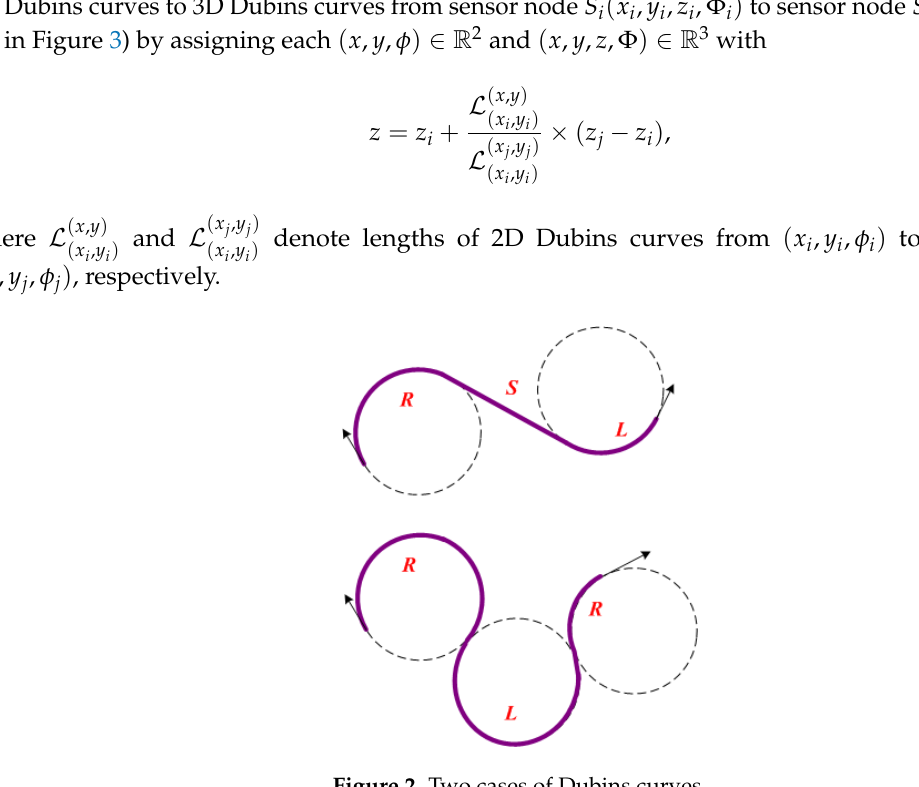
Figure 2. Two cases of Dubins curves.